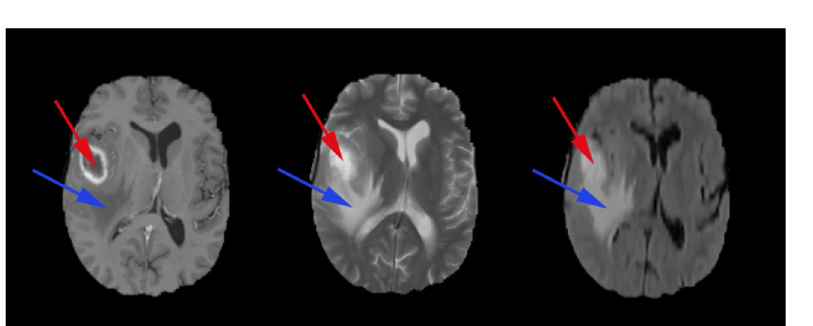
Figure 2. High-grade glioma structure on T1ce, T2 and FLAIR contrast images (from left to right), (red circle) Necrotic core, (blue circle) Perifocal oedema. Source: BraTS